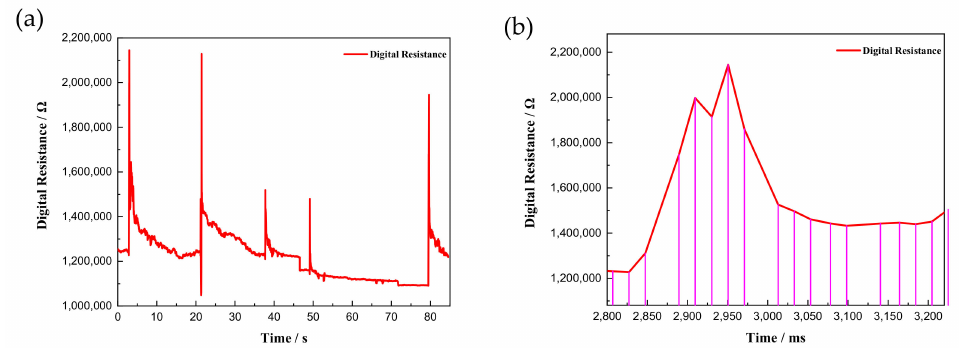
Figure 15. ( a ) Line chart between resistance and time; ( b ) recovery